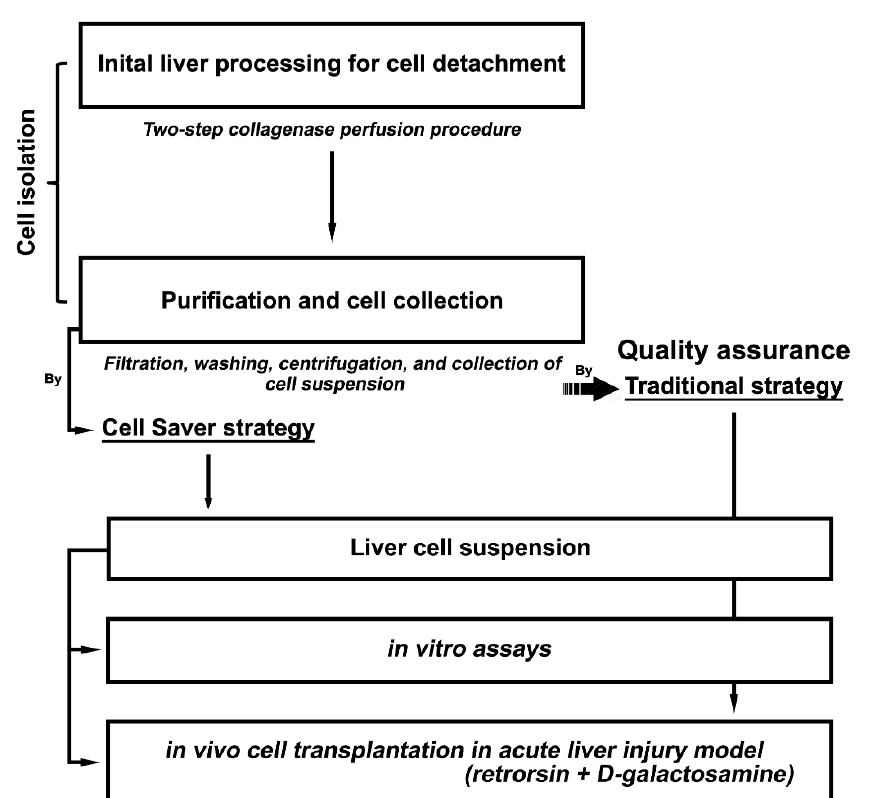
Figure 1. Research and experimental design.